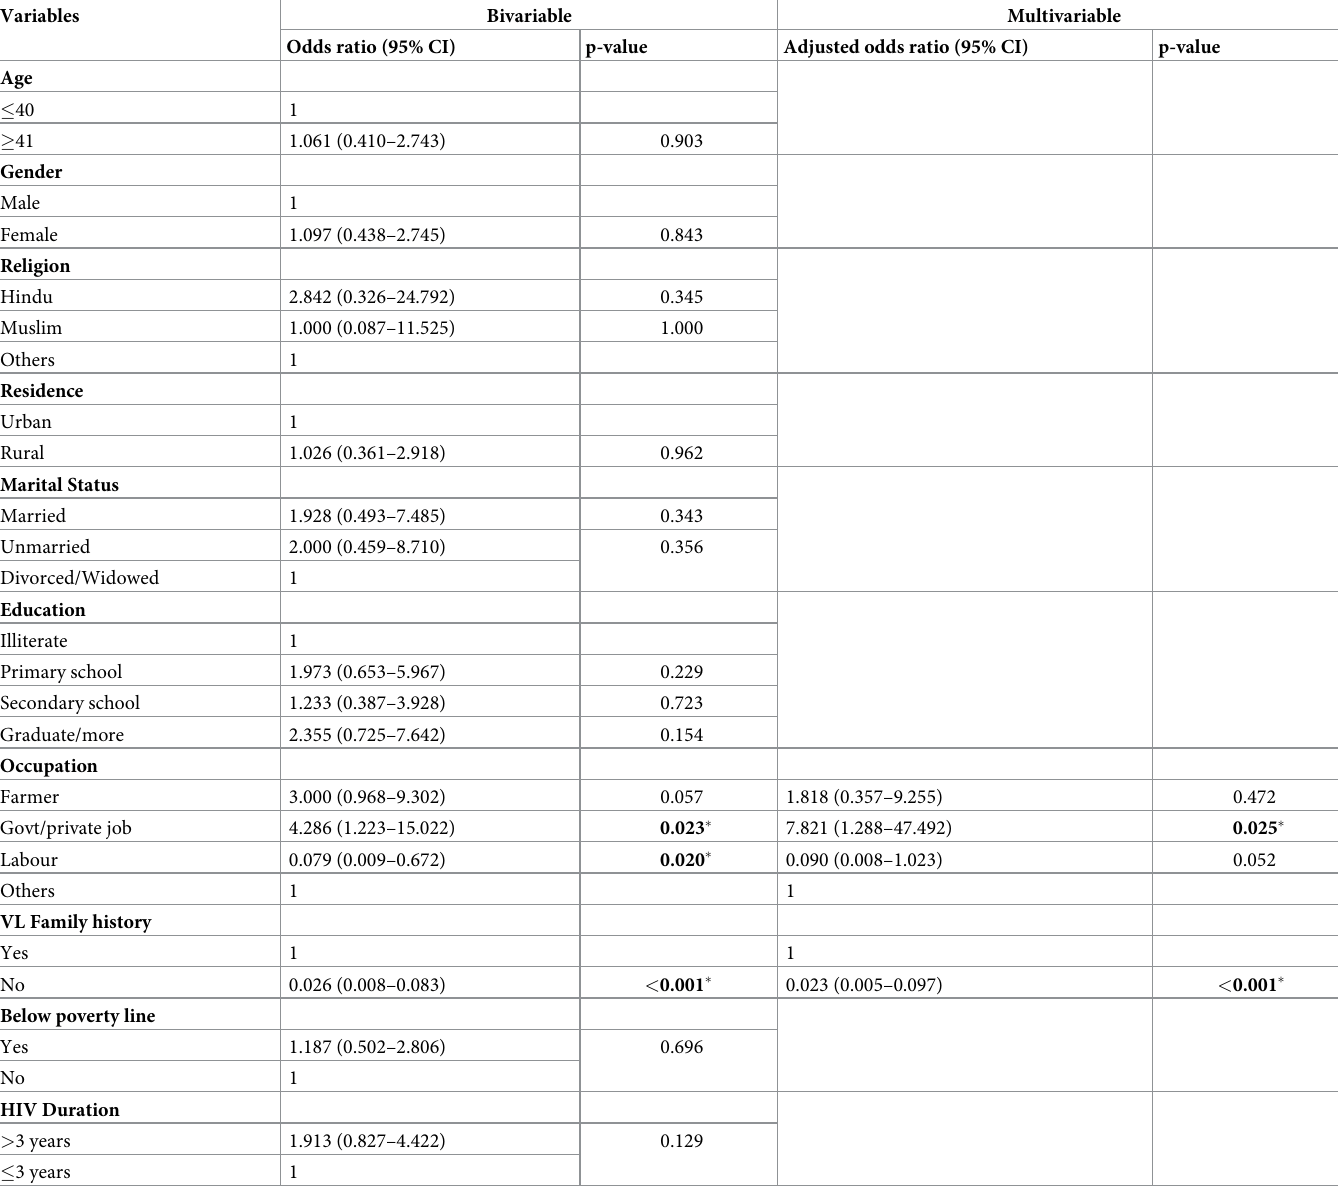
Table 3. Bivariable and multivariable logistic regression analysis showing predictors of knowledge